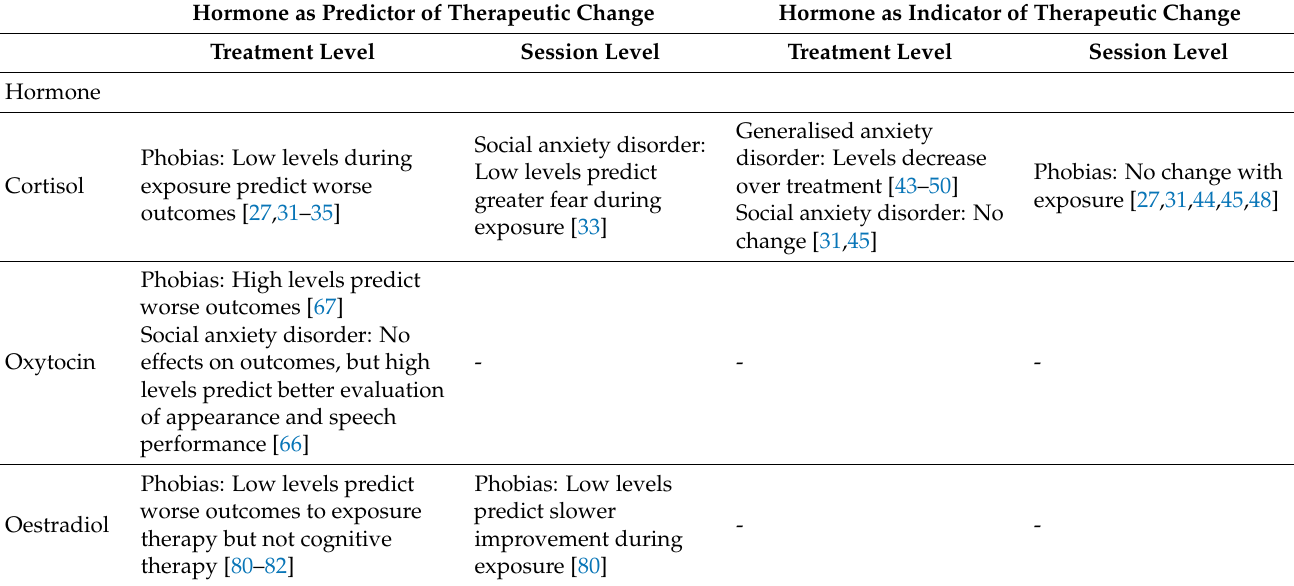
Table 2. Summary of studies investigating the relationship between hormones and psychotherapy in individuals with anxiety